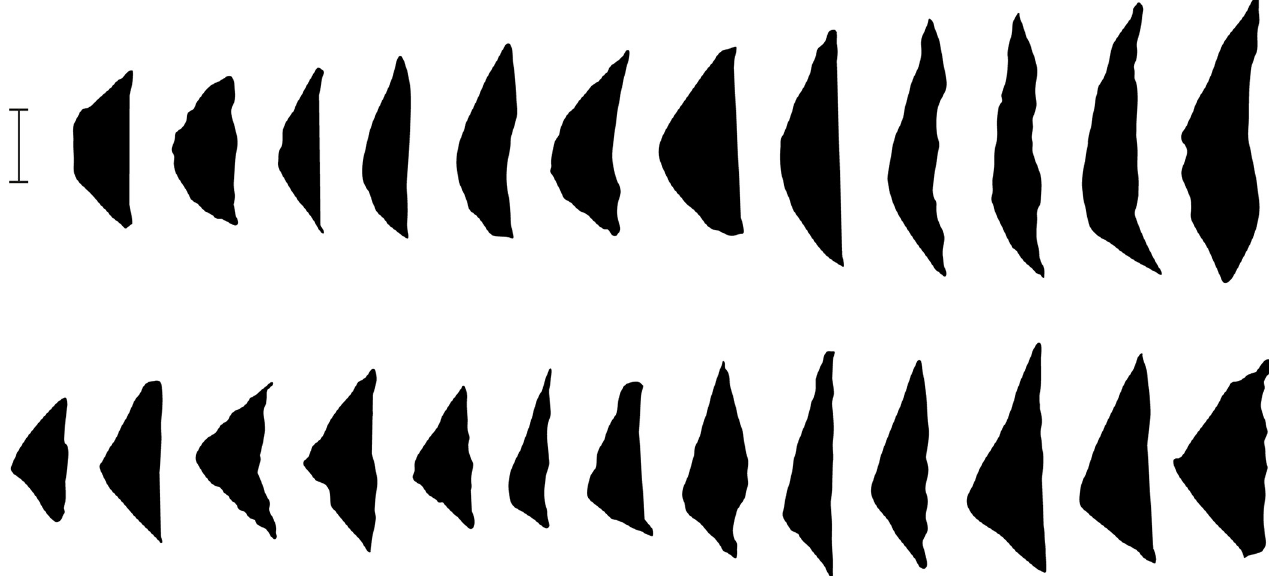
Fig 33. Microlith silhouettes showing the continuous variation in shape Horizon IV, Saruq al-Hadid. Scale bar 10 mm.